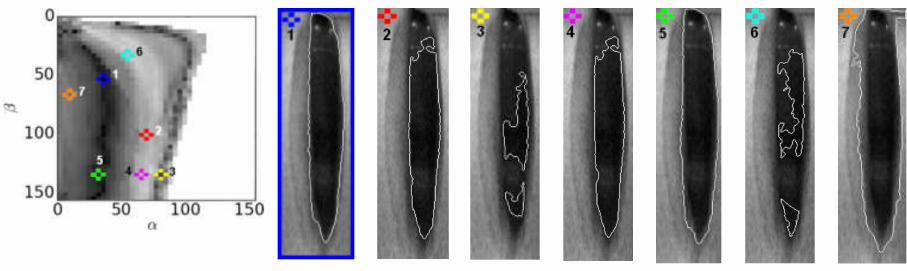
Figure 11. Plot of the cost function map d α , β , (left panel) and example image segmentation results (right panel) obtained for the normophonic subject N2. The segmentation results are obtained for parameters ( α , β ) and assigned different numbers in the cost function plot. The best segmentation result is shown in a thick box on the left side of the right panel and marked with the number